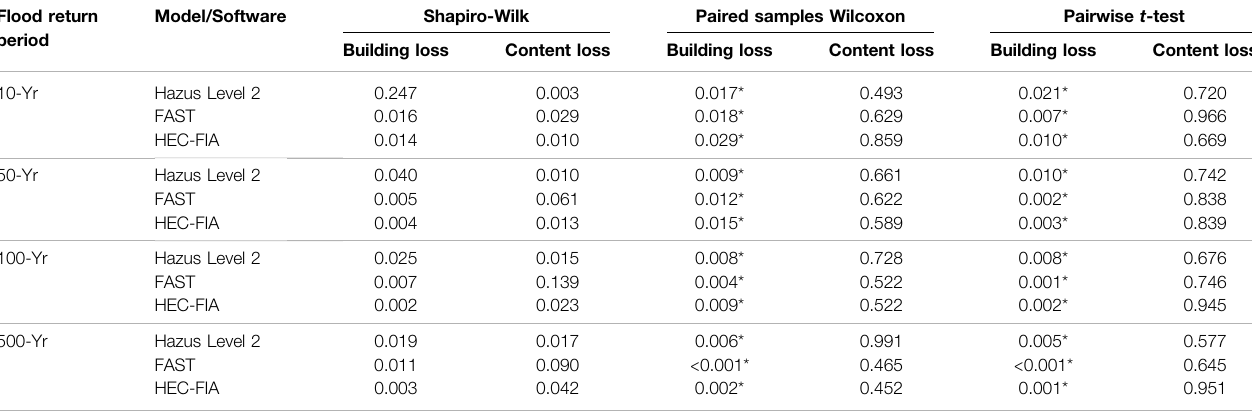
TABLE 8 | p -values of Shapiro-Wilk normality test (with values < 0.05 representing a non-normal distribution) for the distribution of differences between NSI 2.0- and BAD- generated loss estimates (for building and content, separately), and paired samples Wilcoxon and pairwise t -test (with signi fi cant differences at p < 0.05 denoted by an asterisk) of the difference between NSI 2.0- and BAD-generated losses.